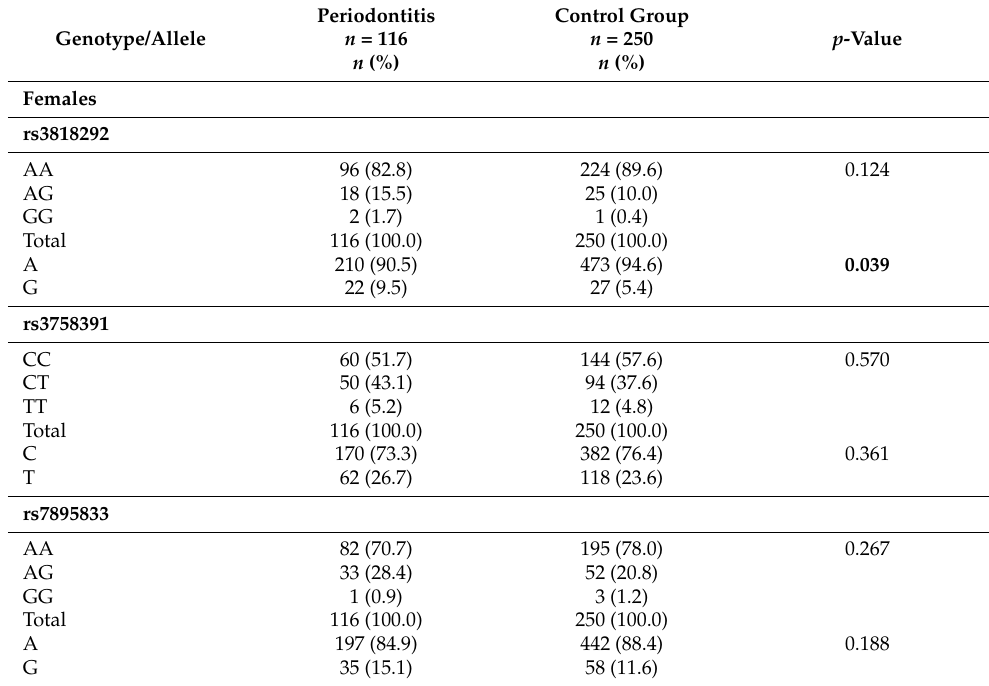
Table 5. Genotype and allele distribution of SIRT1 rs3818292, rs3758391, and rs7895833 in periodonti- tis and control groups between